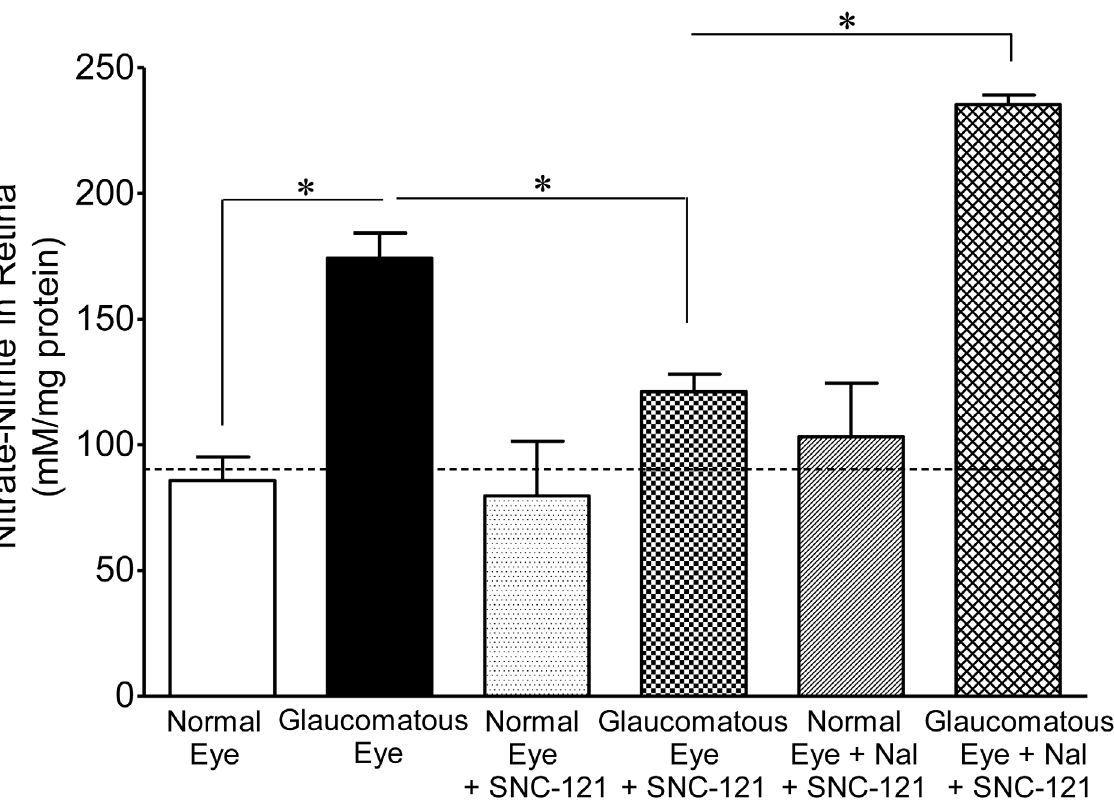
Figure 4. Measurements of nitrate-nitrite in normal and glaucomatous eyes in the presence of SNC-121. Animals were treated with SNC-121 (1 mg/kg, i.p.) 30 minutes after glaucomatous injury, and continued once daily for 7 days. A separate group of animals was pretreated with naltrindole (Nal; 3 mg/kg, i.p.) followed by SNC-121 (1 mg/kg, i.p.) treatment 30 minutes after glaucomatous injury, and continued for 7 days, once daily. The absorbance was read at 550 nm and absorbance was plotted against the nitrate standards. The amount of nitrate-nitrite is expressed as millimolar nitrates-nitrites per milligram protein. Data are expressed as mean 6 SEM, (* P , 0.05; n =4–7).